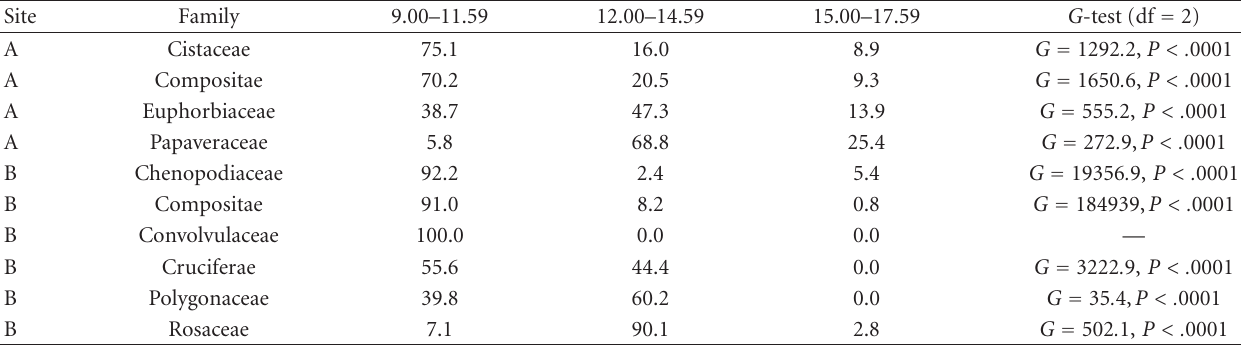
Table 2: Relative abundance of pollen plant families collected by bees in three periods of the day. Only families with abundance > 1% were considered.